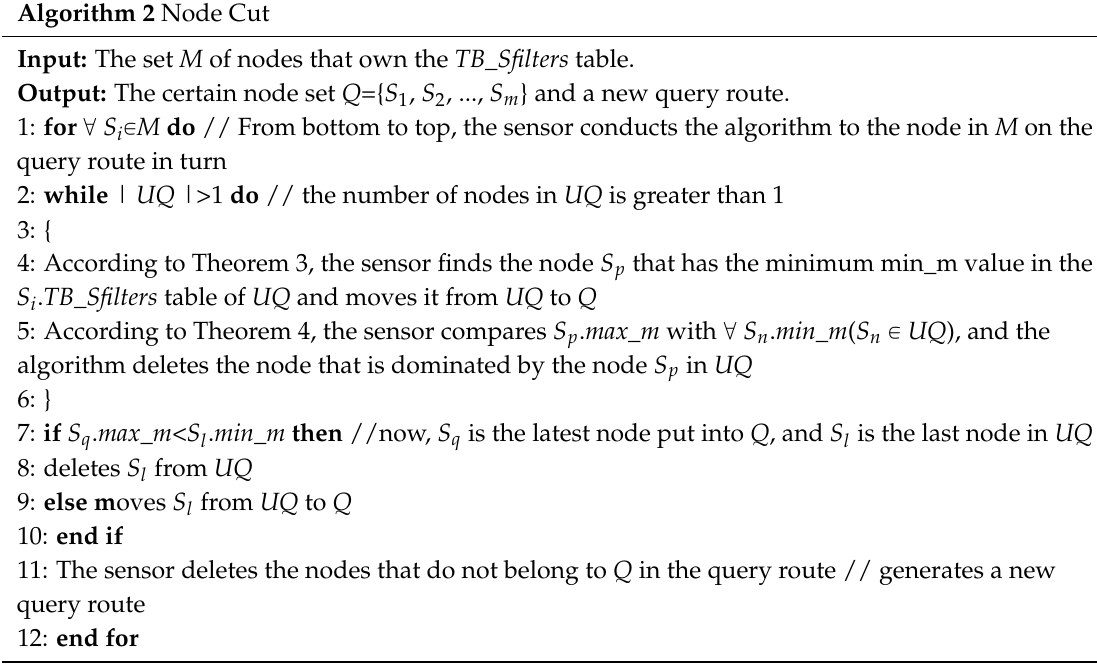
Algorithm 2 Node Cut